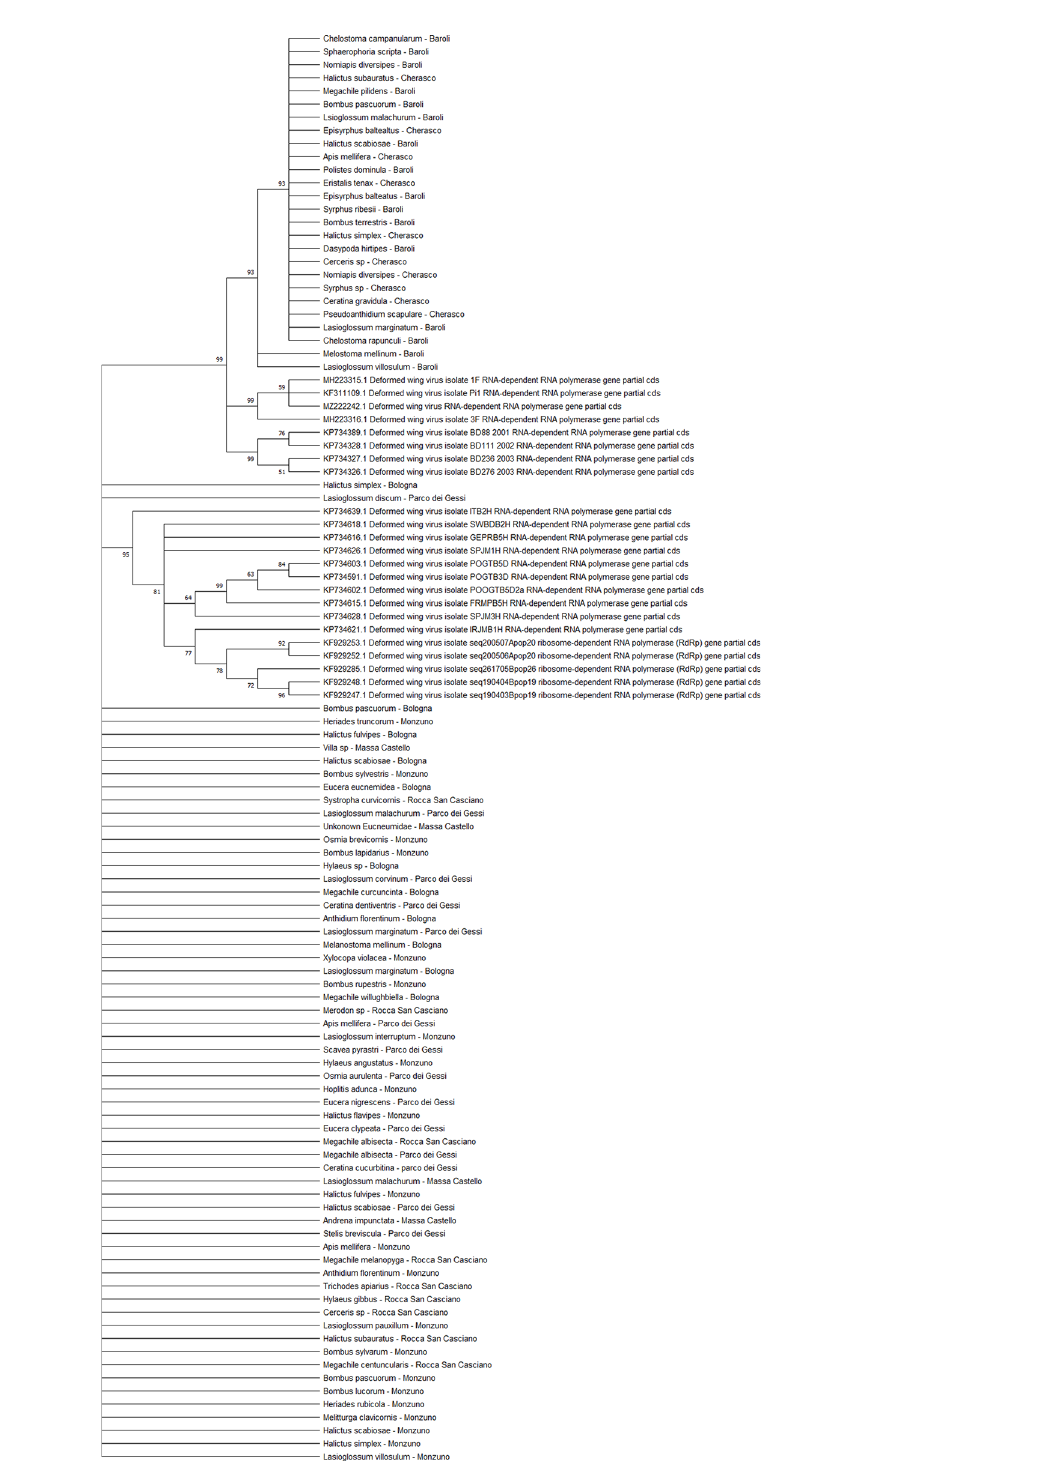
FIGURE 9 | Maximum likelihood nucleotide phylogeny of DWV-A RNA-dependent RNA-polymerase gene. This involved 109 nucleotide sequences. There were a total of 562 positions in the fi nal dataset. Only those with bootstrap > 50% are reported. Species and sampling sites are reported for the sequences identi fi ed in this study. DWV, deformed wing